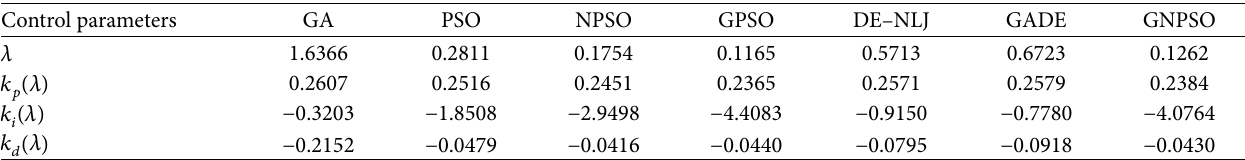
Table 5: Optimization results of IMC-PID controller parameters obtained by GA, PSO, NPSO, GPSO, DE–NLJ, GADE and GNPSO associ- for linear wing vibration system. ated with 𝐹 𝑚𝑎𝑥